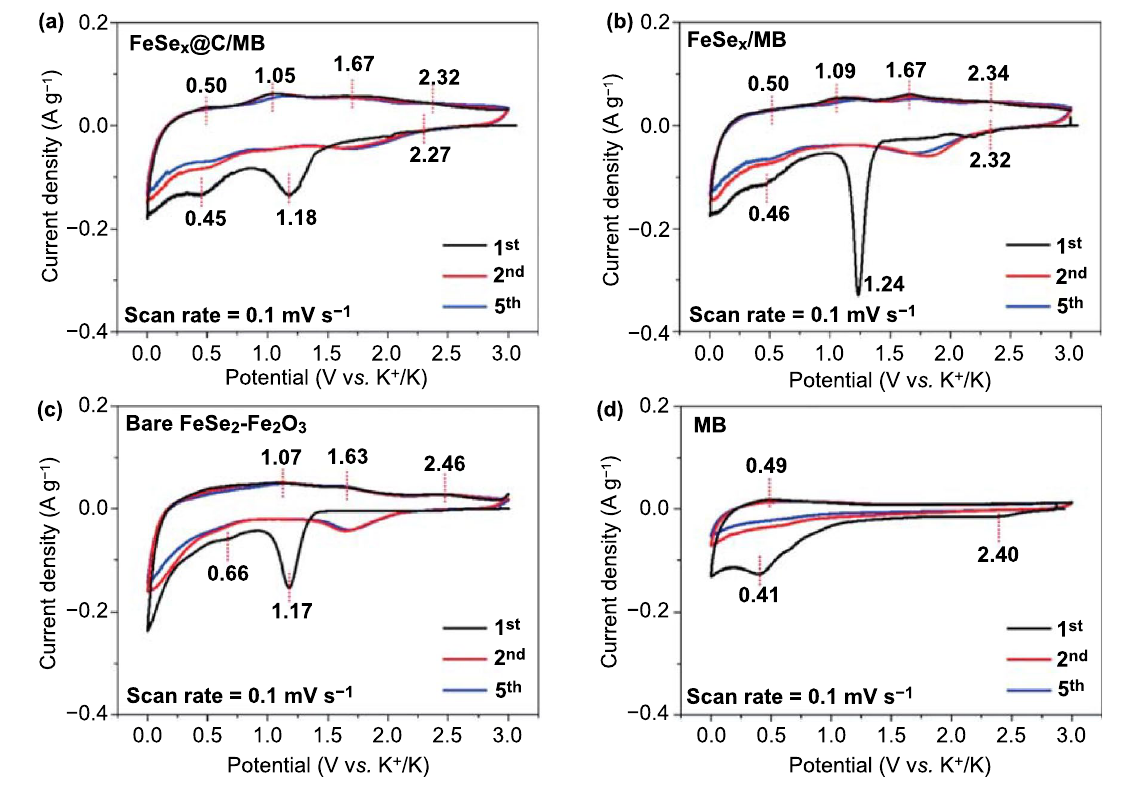
Fig. 7 CV data at voltage range 0.001–3.0 V: a FeSe x @C/MB, b FeSe x /MB, c bare FeSe 2 –Fe 2 O 3 , and d